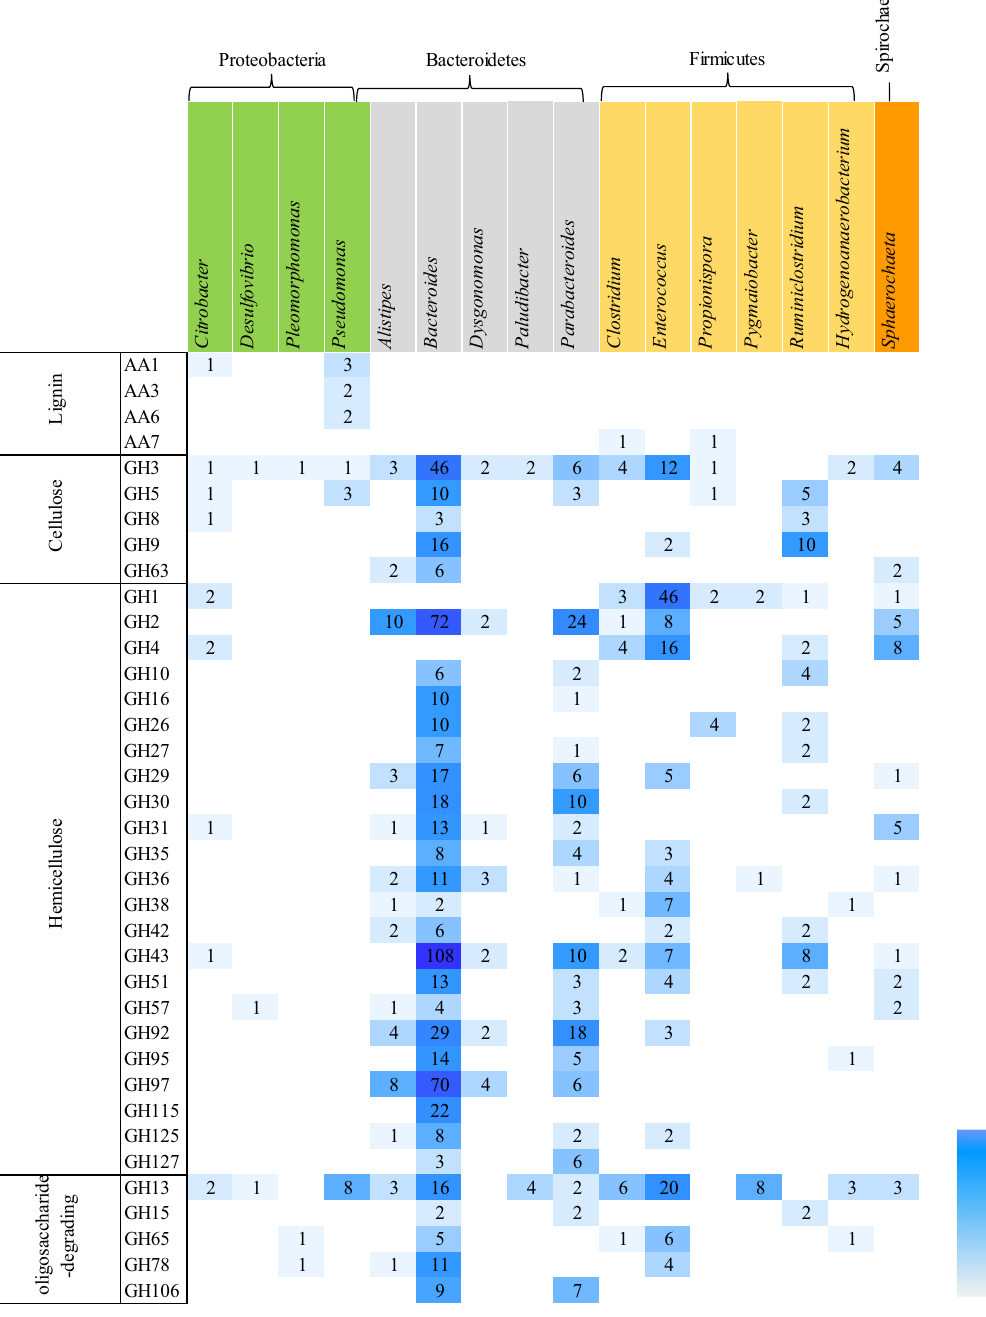
across four phyla. The highest hemicellulolytic GH genes were also observed in the genera Bacteroides and